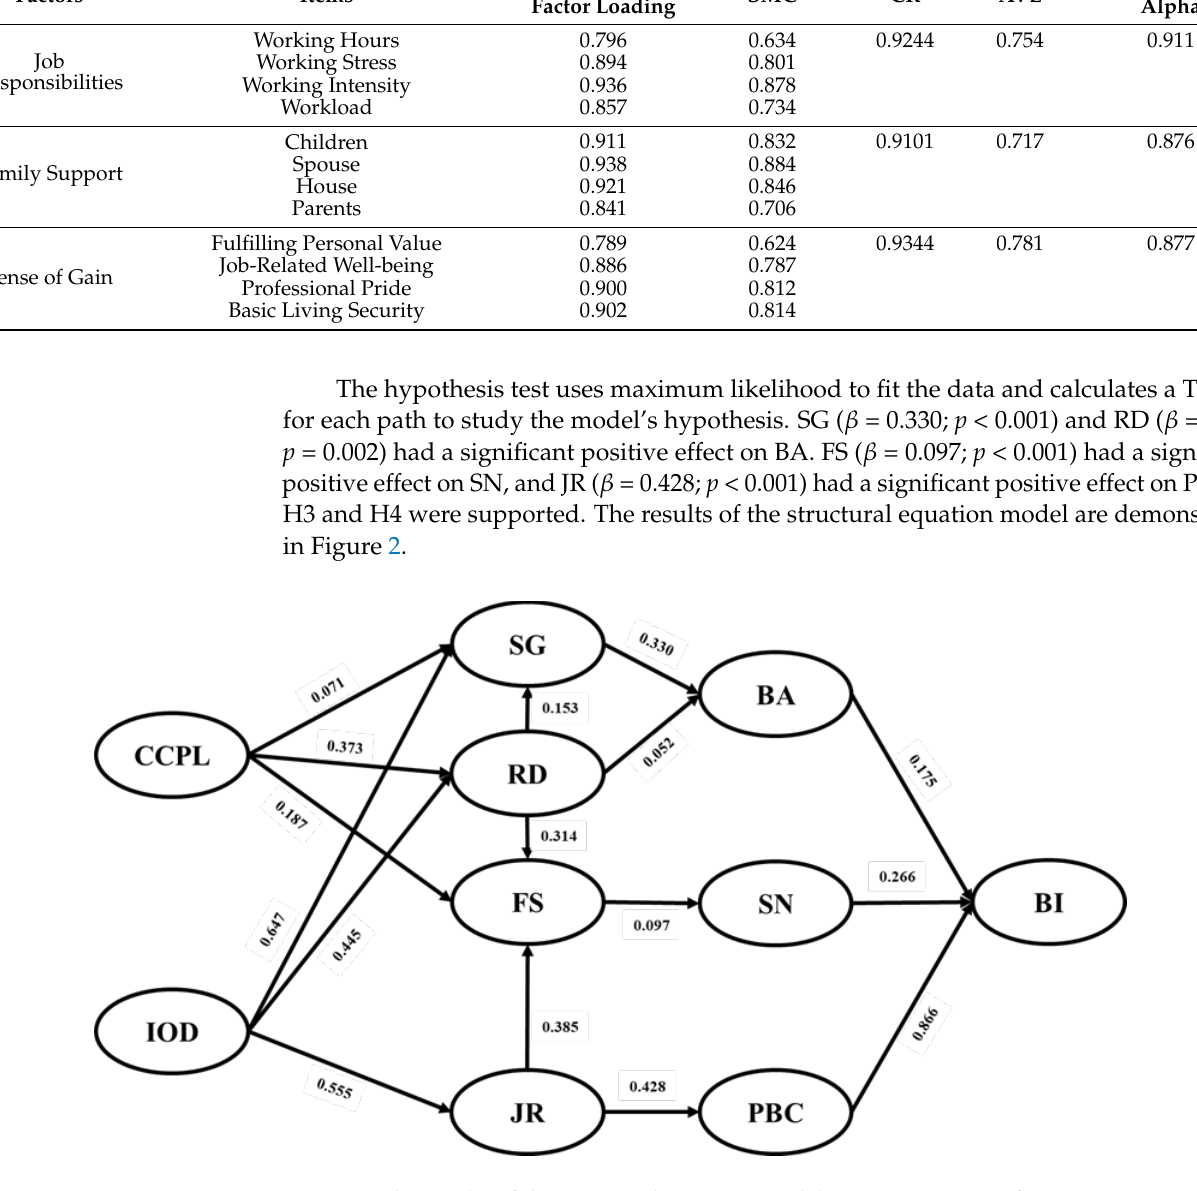
Figure 2. The results of the structural equation model. Note: SG, sense of gain; RD, remuneration and development; IOD, internal organization development; CCPL, condition of the city where the PHCI is located; JR, job responsibilities; FS, family support, BA, behavior attitude; SN subjective norm; PBC, perceived behavioral control; BI, behavior intention.